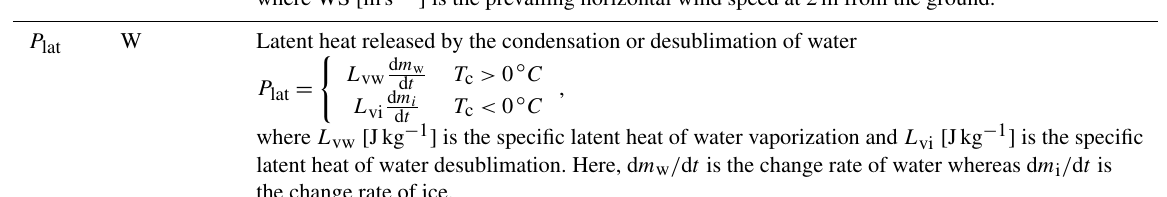
thickness of the condenser